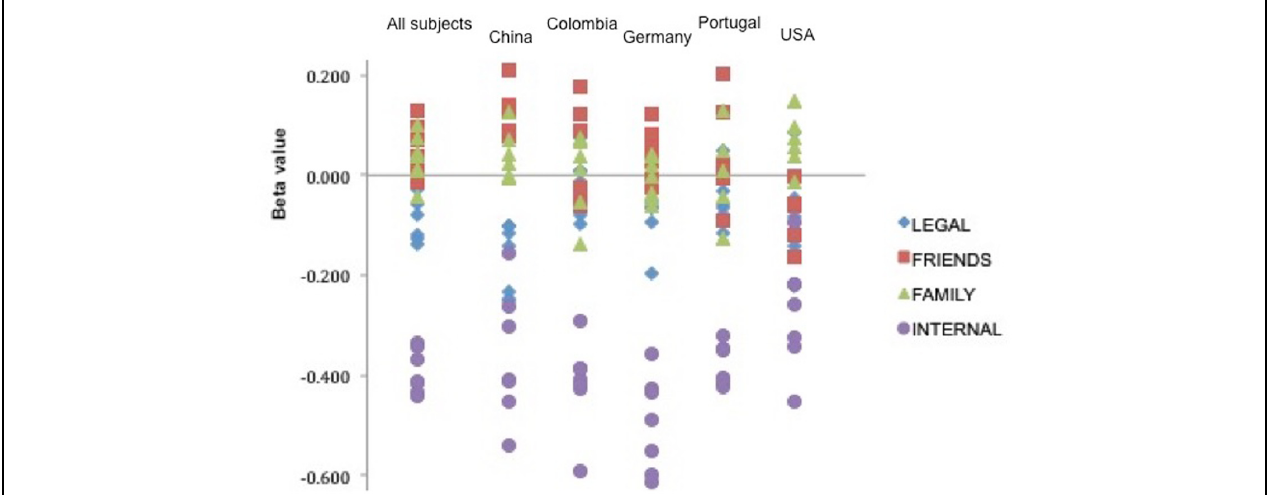
FIGURE 2 | Summary of the beta values for legal, friends, family, and internal product variables entered as predictor variables in linear regression analyses. For each item, sanction product variables were entered as predictors with self-reported likelihood of engaging in the action entered as the dependent